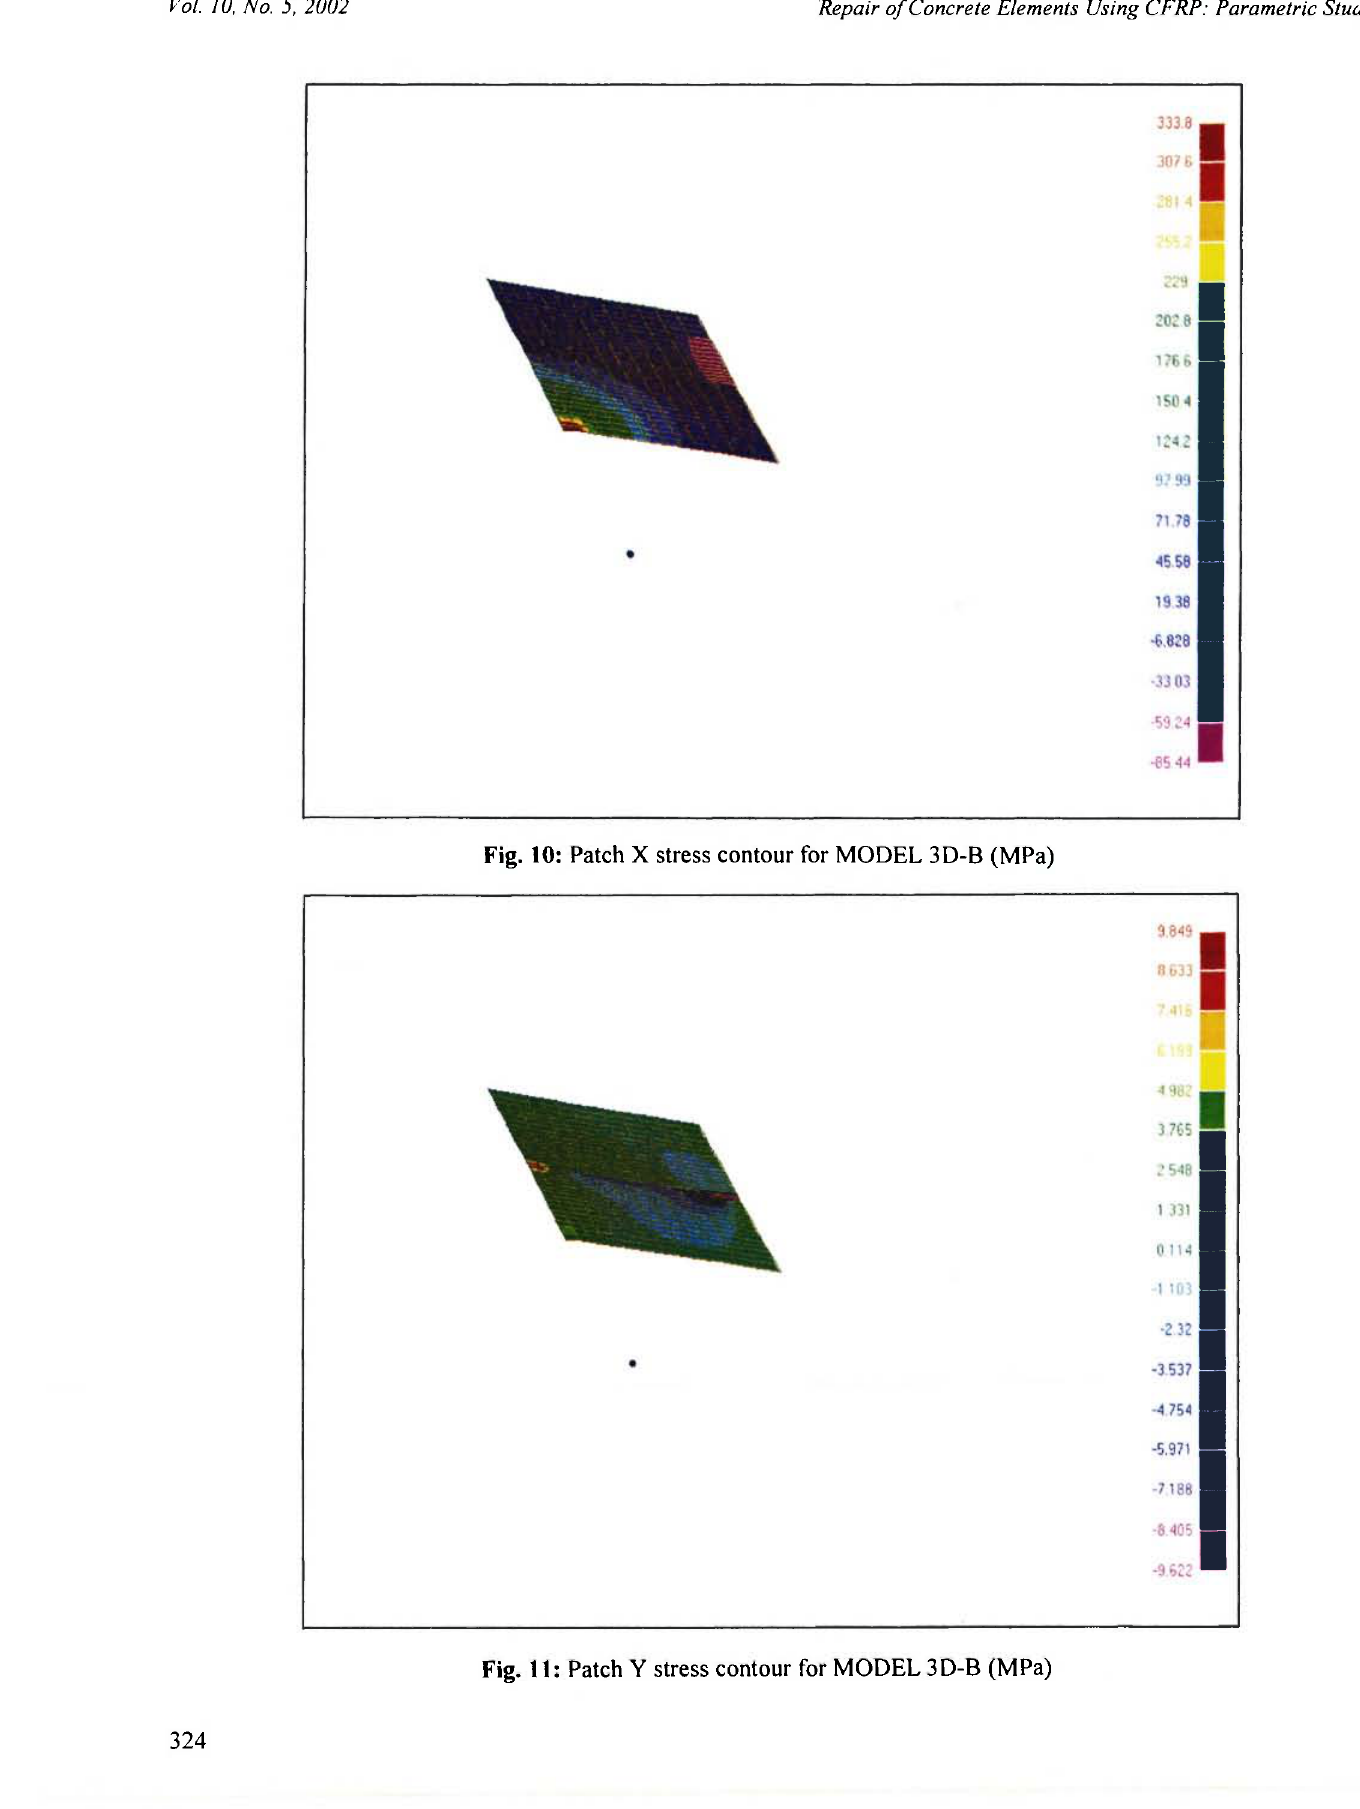
Fig. 10: Patch X stress contour for MODEL 3D-B (MPa)